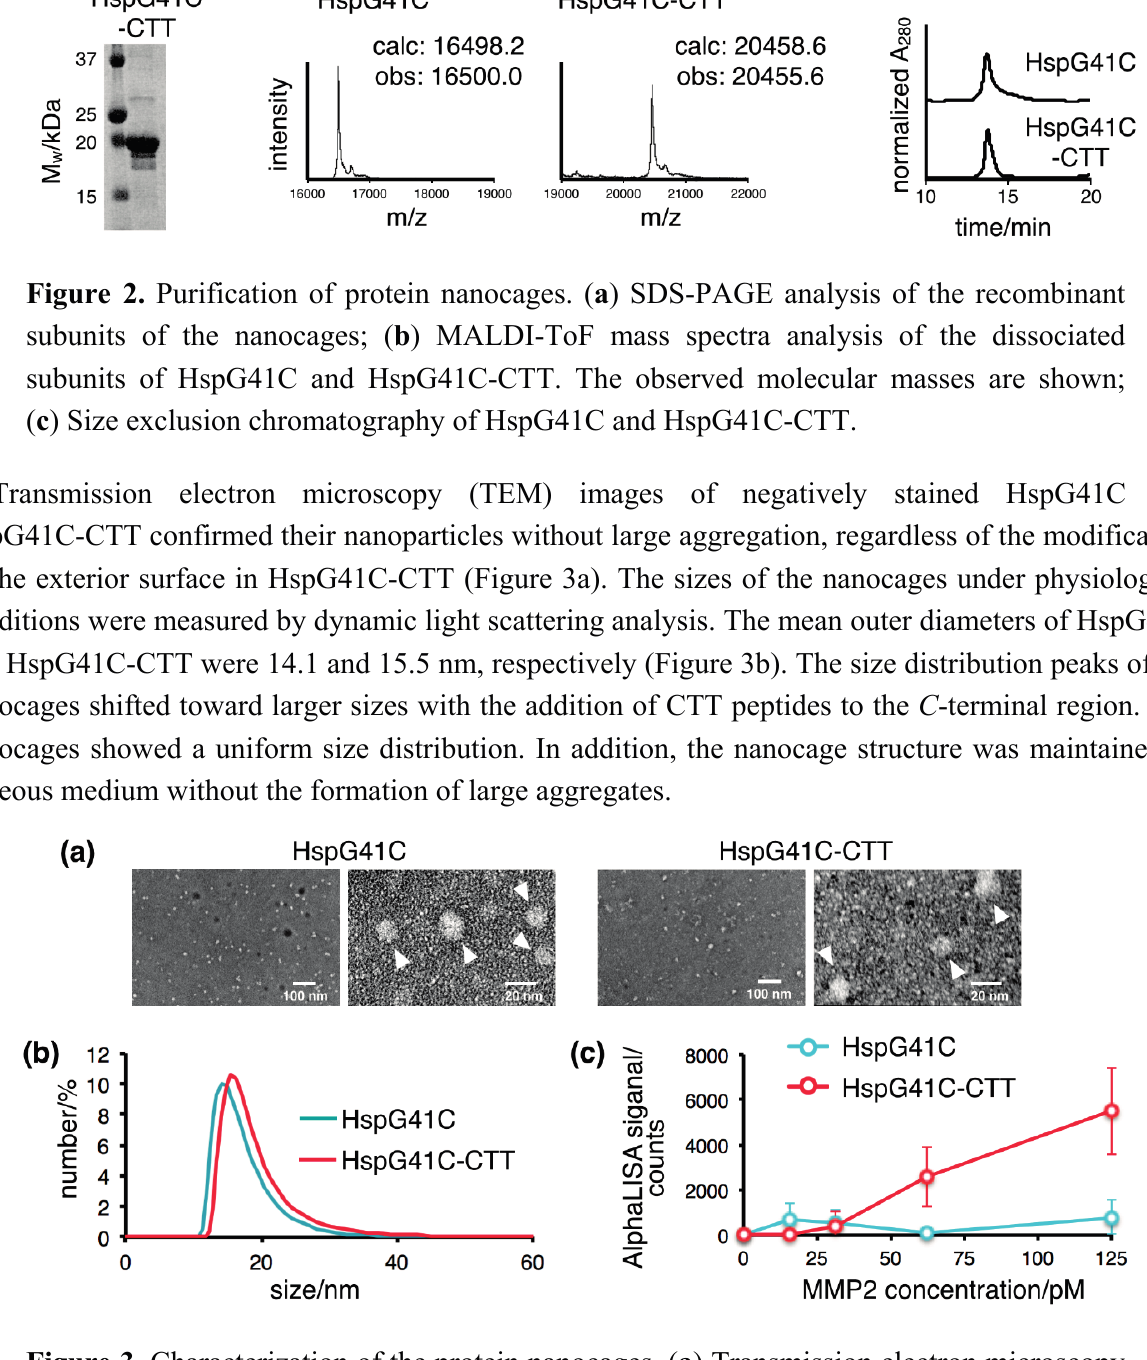
Figure 3. Characterization of the protein nanocages. ( a ) Transmission electron microscopy images of the nanocages. White arrows show the nanocages; ( b ) Dynamic light scattering profiles of the nanocages in phosphate-buffered saline; ( c ) AlphaScreen binding assay of the nanocages with